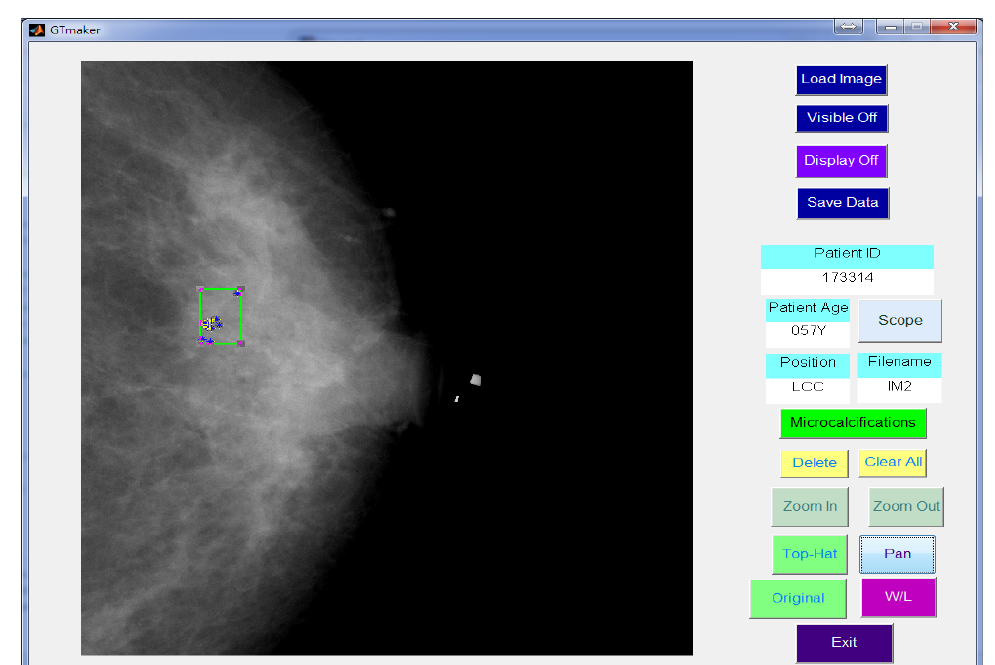
Figure 7. A GUI was designed for manual identification of MCs and